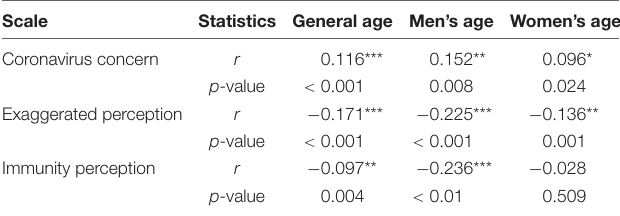
TABLE 4 | Relationship between CAS-10 subscales and age, compared by the respondent’s